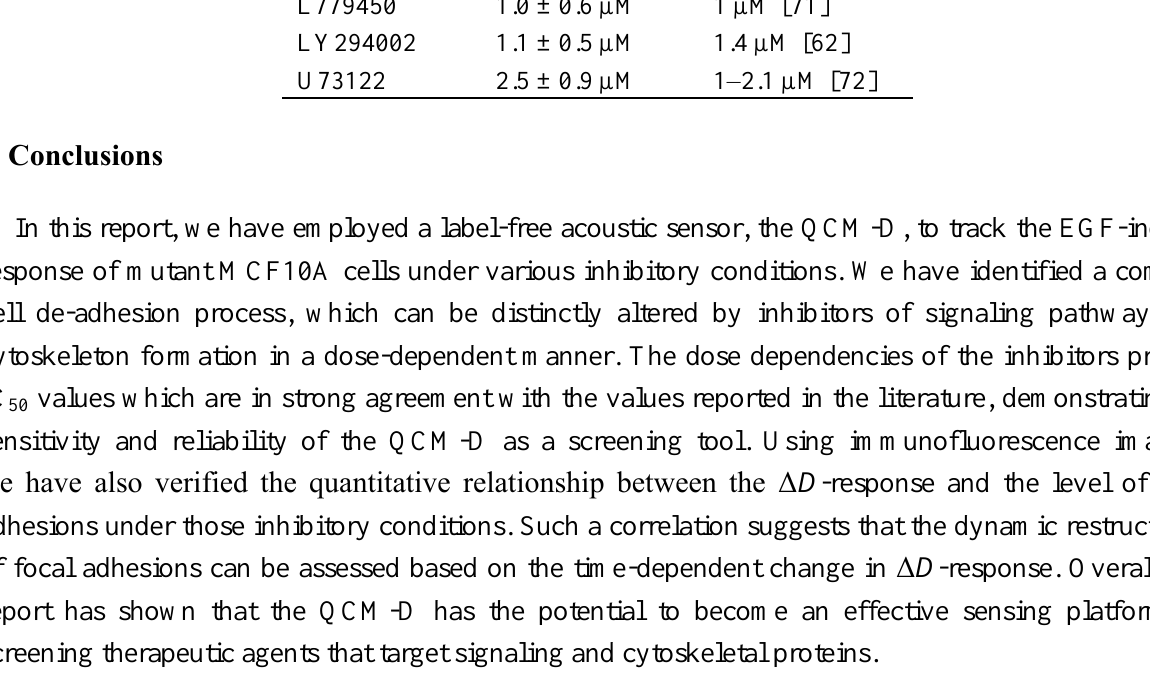
Table 1. Comparison of IC